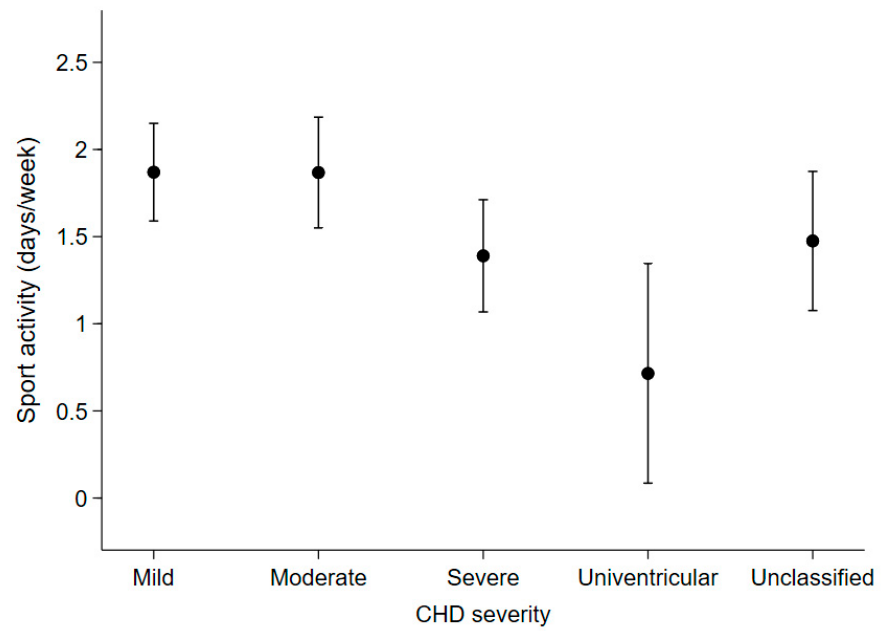
Figure 5. Expected number of days spent per week on sports activities in the last year according to disease severity in the 266 patients who were contactable by telephone at the end of the